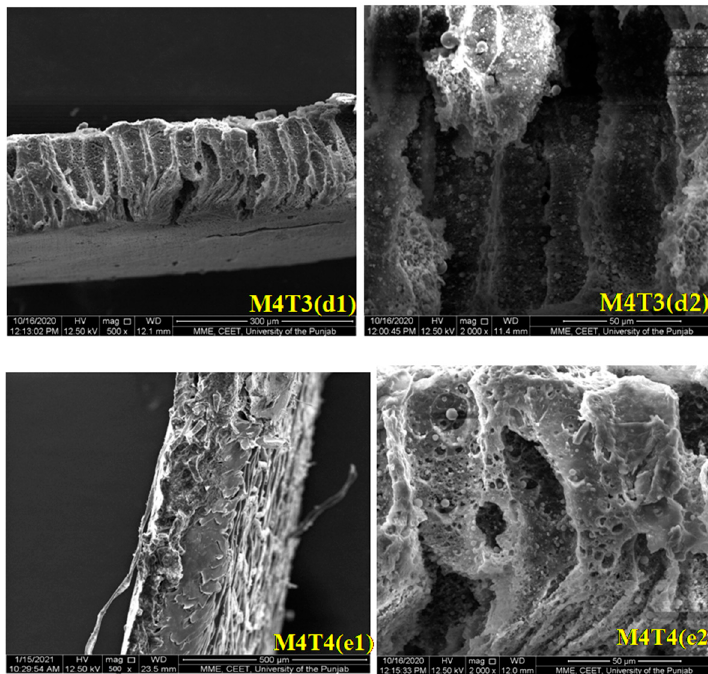
Figure 3. Cross-sectional SEM images of M4, M4T1, M4T2, M4T3, and M4T4.